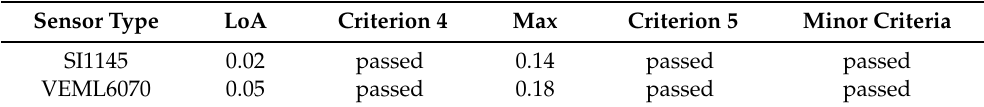
Table 12. Comparison of worst-case differences between data from UV index sensors and data from the reference weather